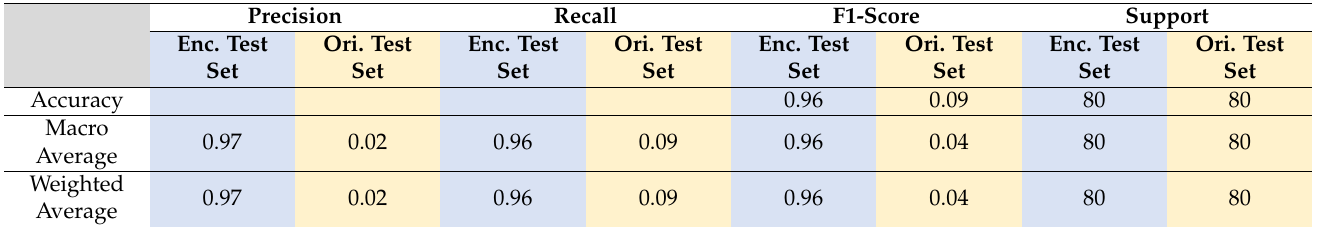
Table 9. Evaluation metrics report with random forest classifier. Highlighted in blue are results in encrypted test set and orange represents results on original test